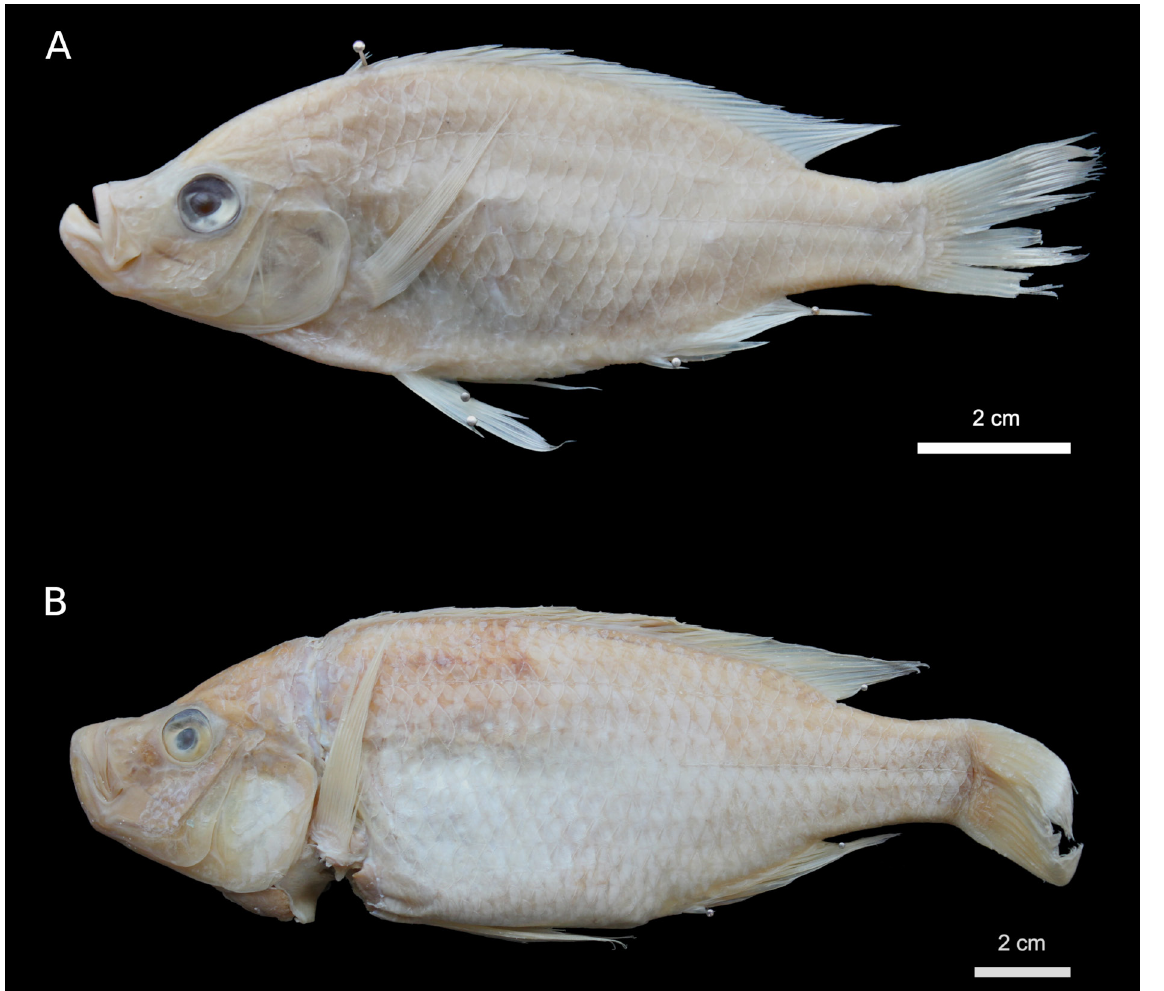
Fig. 4. Photographs of preserved specimens of Protomelas krampus sp. nov. A . Holotype (RMCA 99- 041-P-4768). B . Paratype (RMCA 99-041-P-4767). Melanin pattern strongly